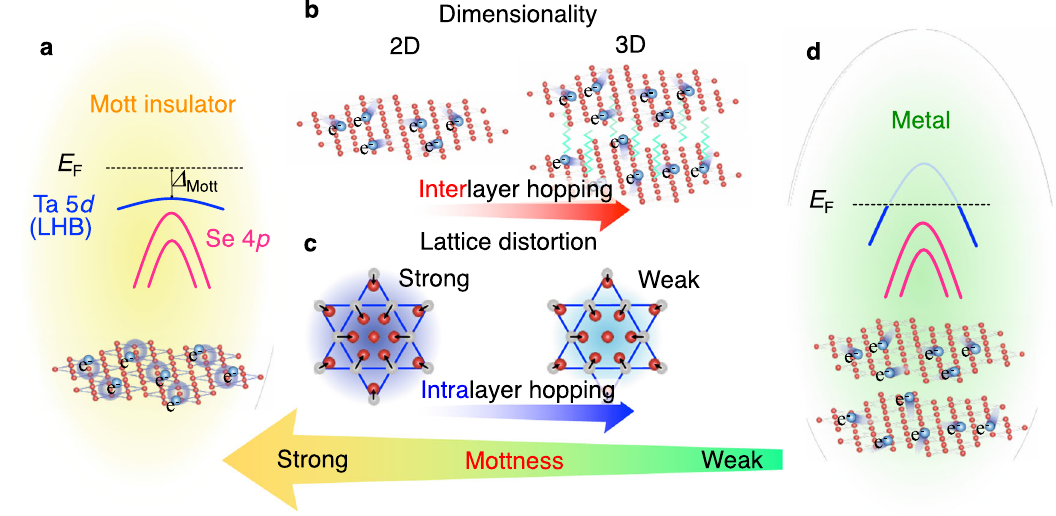
Fig. 5 Realization of 2D CDW – Mott insulator phase assisted by strong lattice distortion. a Schematics of (top) the band dispersion and (bottom) the star-of-David clusters in the robust CDW – Mott phase in monolayer TaSe 2 . b Illustration to compare the interlayer hopping in the crystal in 2D and 3D systems. c Illustration of strong vs weak lattice distortion in the star-of-David cluster and its relationship with the intralayer hopping in the CDW phase. d Schematics of (top) the normal-state band dispersion and (bottom) the bulk crystal structure without CDW